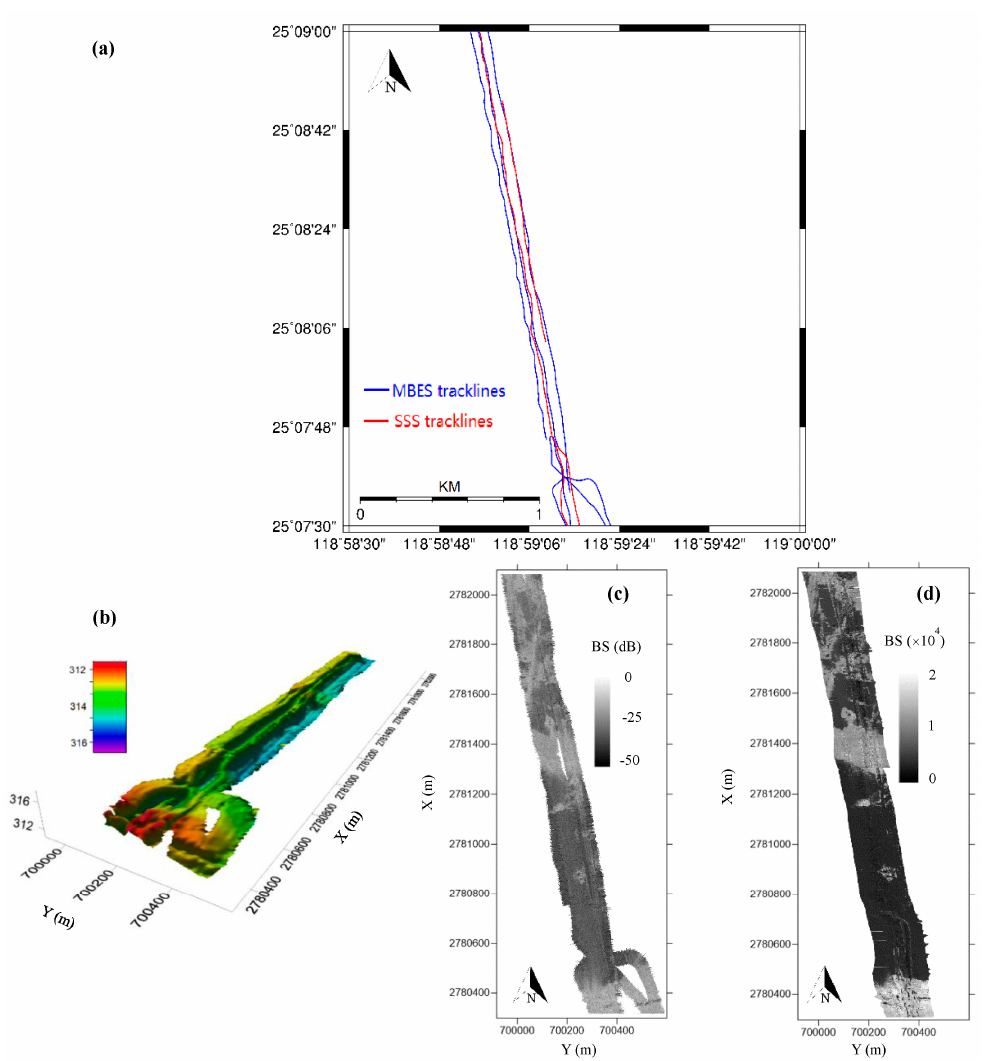
Figure 9. ( a ) Tracks of MBES and SSS survey lines in the measurement area; ( b ) digital elevation model (DEM) established by MBES sounding data; ( c , d ) the geocoded MBES snippet and SSS images.